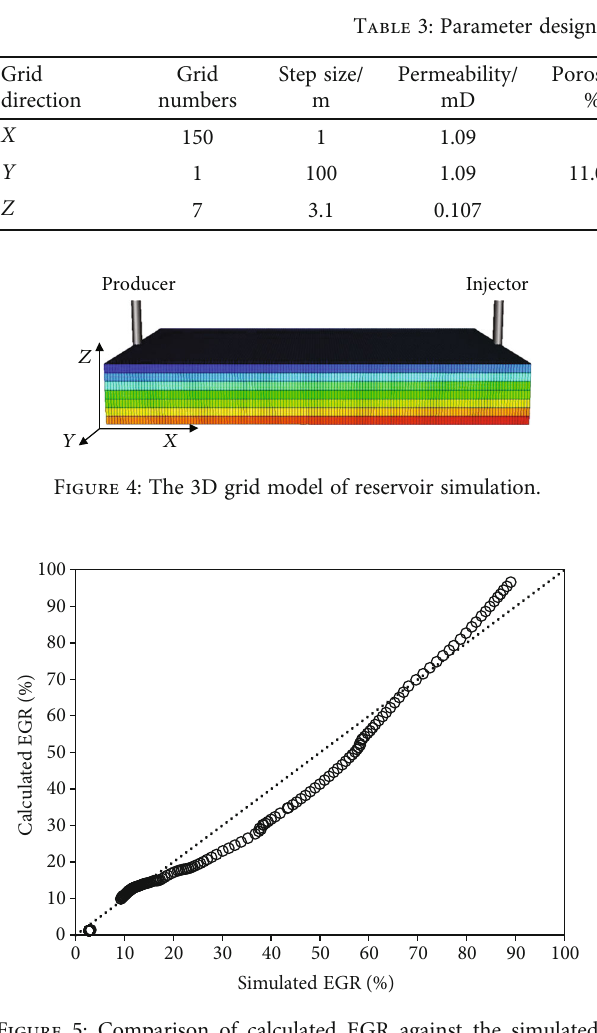
Figure 5: Comparison of calculated EGR against the simulated values, LPG : NG < 50 % . The dashed lines indicate relative errors equal to zero.